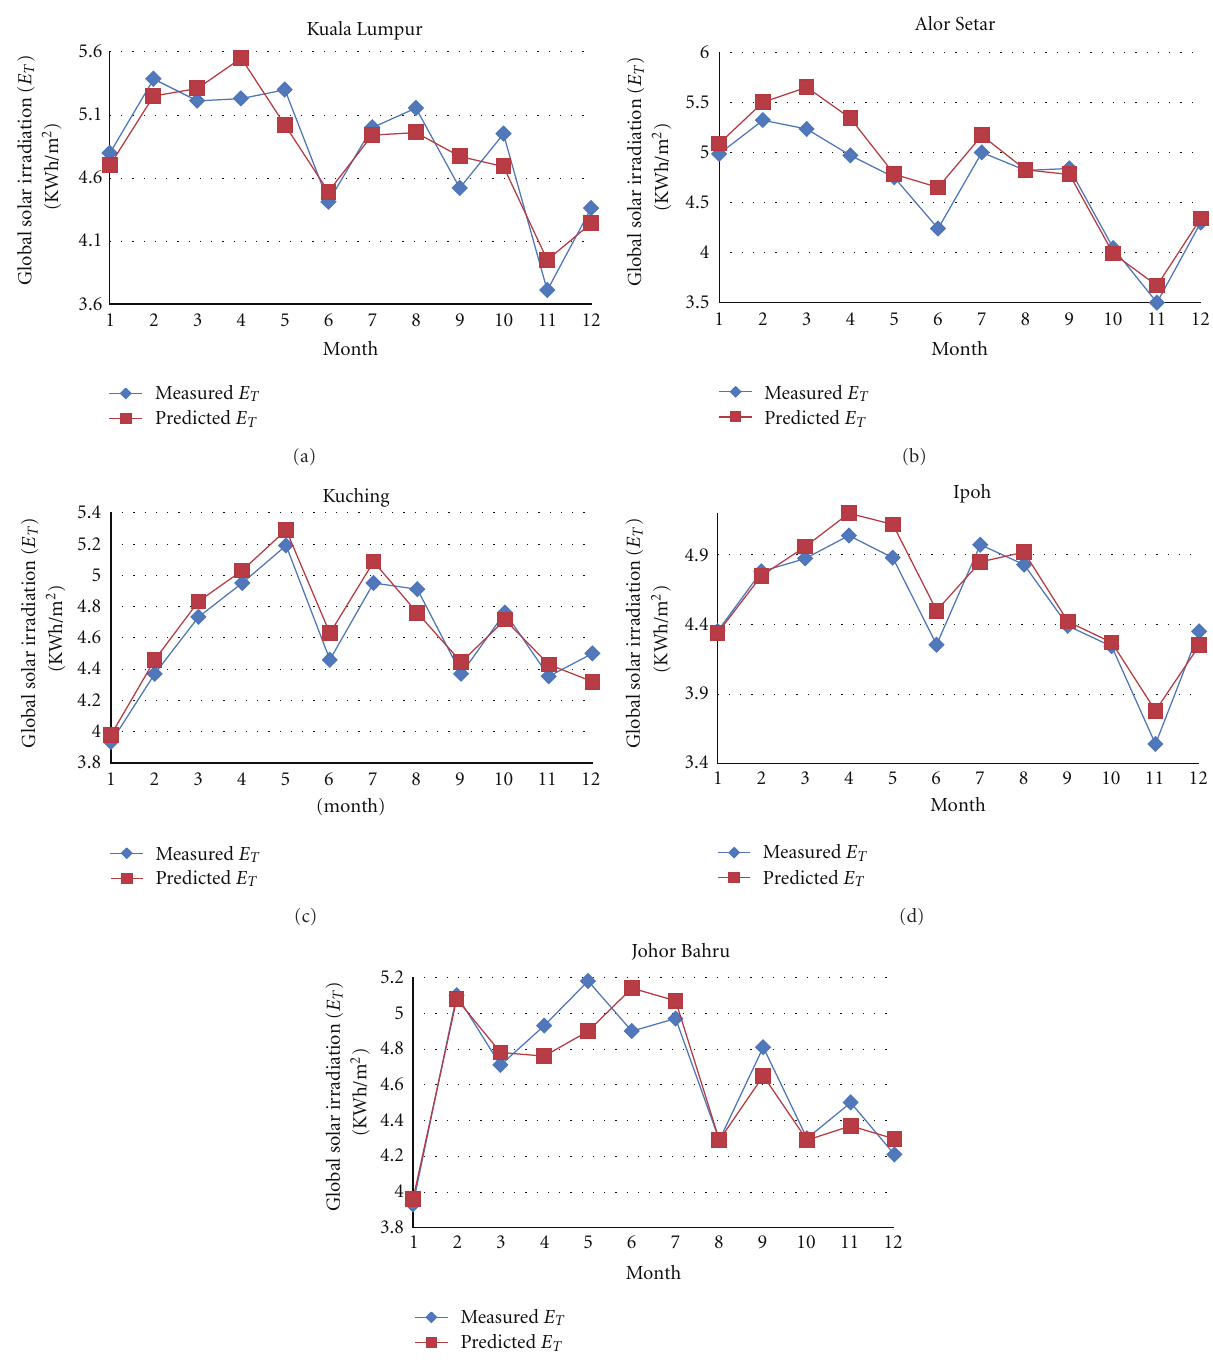
Figure 8: Comparison between the monthly average of the predicted and the measured global solar irradiations.